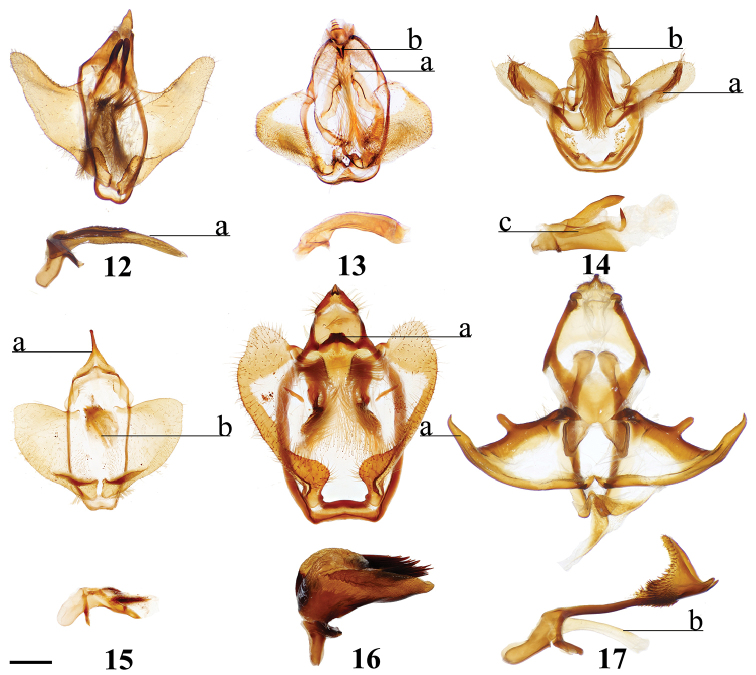
Ventral view of male genitalia of type species (except where noted) of genera belonging to Lacosominae: Alheitini. Phallus/juxtal complex is figured below the genitalia in the lateral view. 12Adalgisacroesa, St Laurent diss.: 9-20-17:1 (CRAS) 13Alheitarionica, St Laurent diss.: 3-27-17:2, not the type species of Alheita [reused with permission from St Laurent et al. (2018a), Systematic Entomology] (CRAS) 14Taremarivara, St Laurent diss.: 3-14-16:7 [reused with permission from St Laurent et al. (2017b), ZooKeys] (CNC) 15Herbinallacaudina, St Laurent diss. 10-8-14:1 [reused with permission from St Laurent et al. (2018a), Systematic Entomology] (CUIC) 16Thaeliacfbeniensis, St Laurent diss.: 4-5-16:1, not the type species of Thaelia (USNM) 17Arianulahaxairei, St Laurent diss.: LEP50135 [reused with permission from St Laurent et al. (2018a), Systematic Entomology] (MGCL). Scale bar: 1 mm.